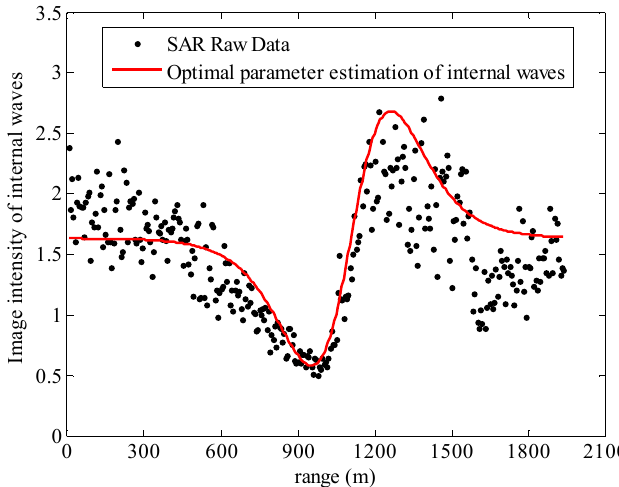
Figure 8. The validation of the optimal parameter estimation of internal waves.